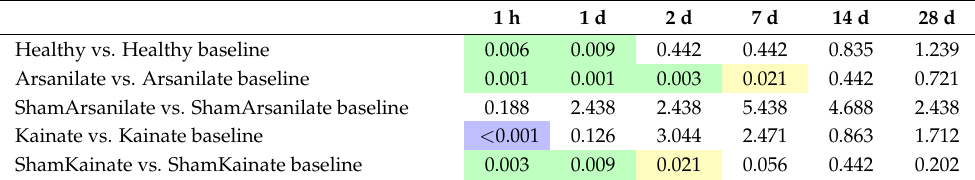
Table A4. Bonferroni-corrected p values for fraction of the sphere visited during movement (one-sided Wilcoxon test; p values lower than 0.05, 0.01 and 0.001 are highlighted in yellow, green and blue,